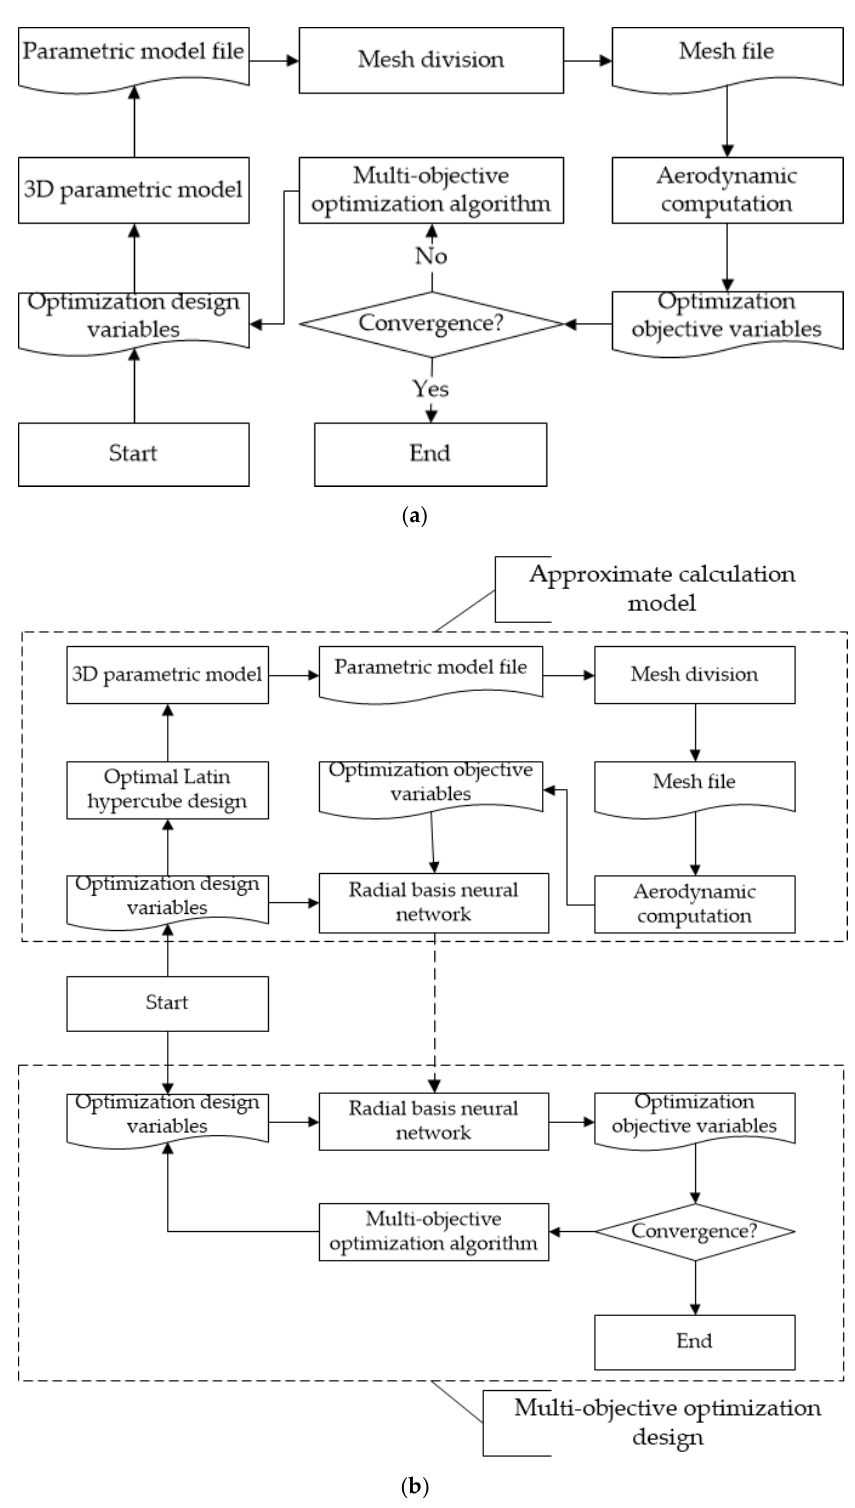
Figure 1. Optimization process of streamlined head shape: ( a ) Direct optimization process, ( b ) Optimization process based on approximate model.